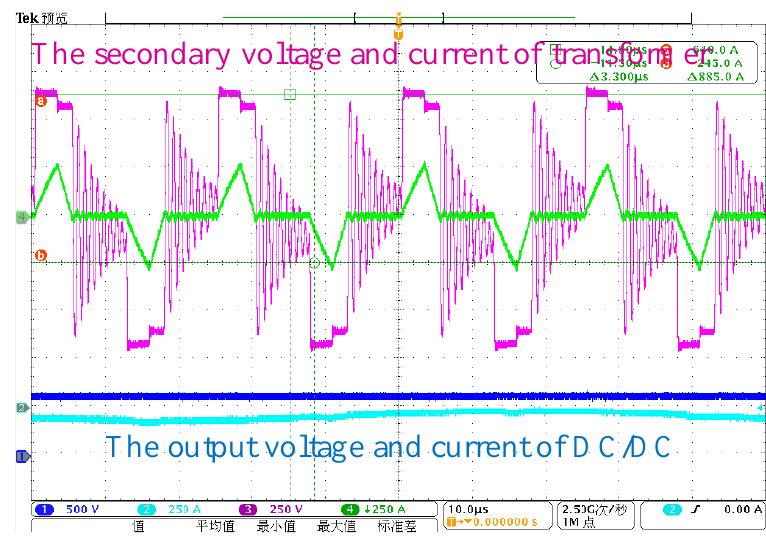
Figure A2. The waveform for rectifier loss.